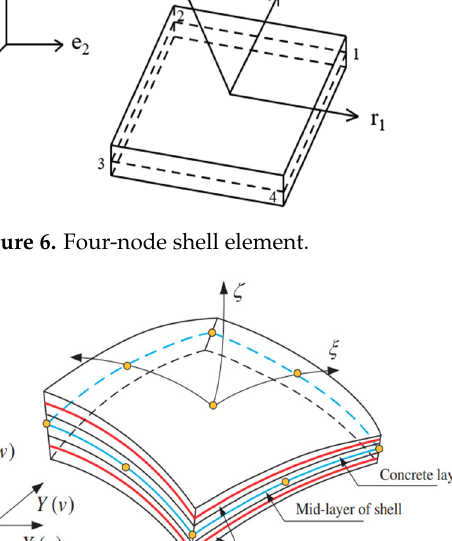
stress output Figure 8. Stress extraction process.